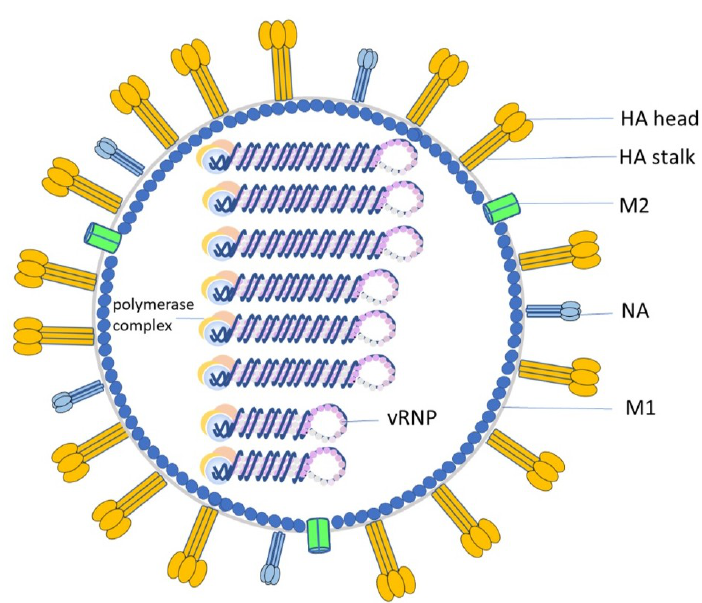
Figure 1. Schematic view of influenza virion. Hemagglutinin (HA), neuraminidase (NA) and matrix protein 2 (M2) are the proteins expressed on virus membrane. Trimeric HA protein consists of HA head and HA stalk. Viral ribonucleoprotein (vRNP) is composed of vRNA and nucleoprotein (NP, light purple). Viral polymerase complex includes polymerase basic proteins 1 (PB1, blue), 2 (PB2, tan) and acidic protein A (PA, light yellow). The matrix protein (M1) is a multi-functional protein involved in influenza virion assembly and infection.